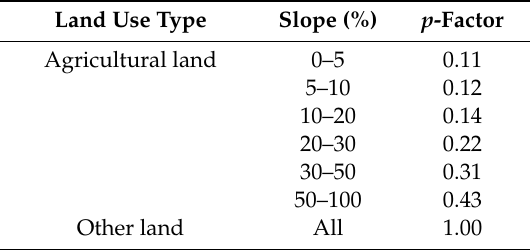
Table 4. Conservation factor ( p )